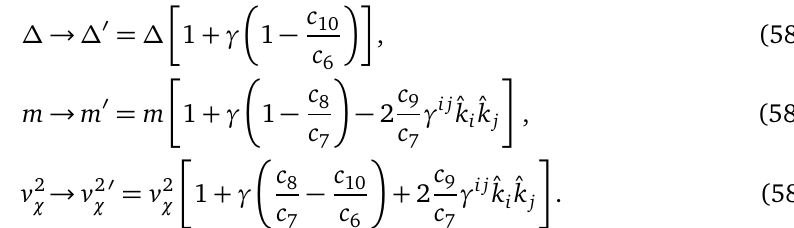
Figure 2: Feynman diagram describing the emission of a phonon from a